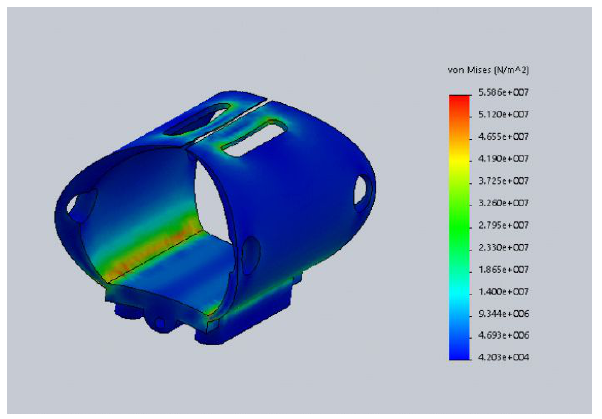
Figure 9: First design prepared and simulated for the finger ring segment